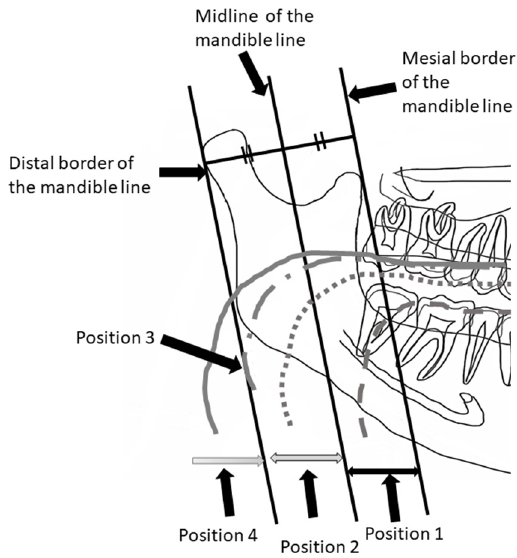
Figure 6. Width of the tongue. The location where the outer border of tongue overlapped the ana- tomical structure was assessed.